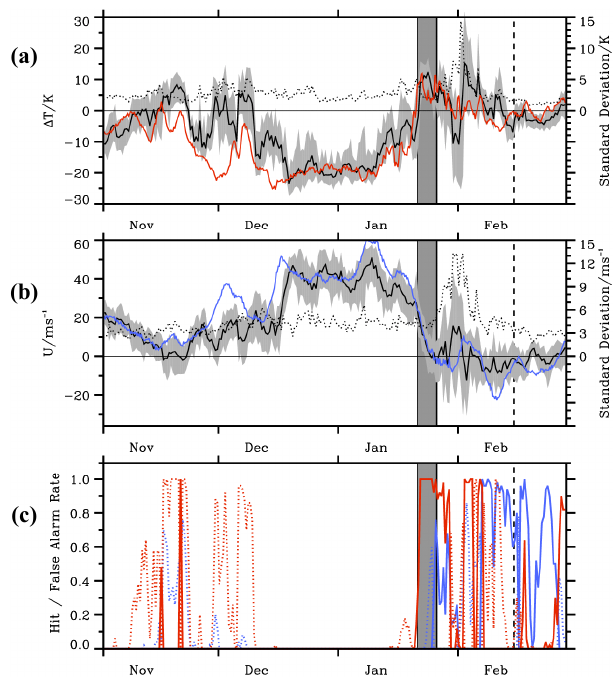
Fig. 12. Major warming criteria for a forecast lead time of 240h. (a) Meridional difference 1T of the zonally averaged temperature between 85 and 60 ◦ N at 10hPa. (b) Zonally averaged zonal wind U at 60 ◦ N and 10hPa. Red and blue lines in (a) and (b) denote the verifying analyses, respectively. The gray shaded area encloses the minimum and maximum values of all EPS members, the solid black line mark the ensemble mean, and the dotted lines the respec- tive standard deviations σ 1T and σ U defined among the ensemble members around the corresponding ensemble means. (c) Hit rates (solid lines) and false alarm rates (dotted lines) assigned to the fore- casted days of the EPS members satisfying the SSW criteria for U (blue) and 1T (red),